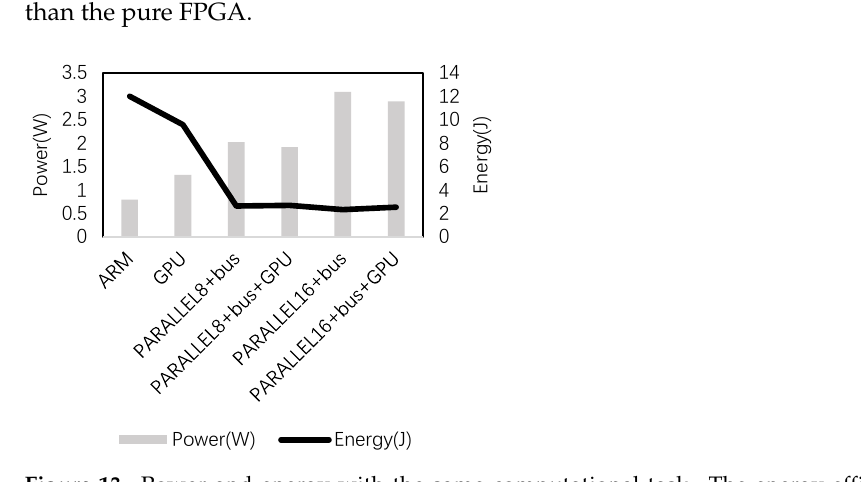
Figure 13. Power and energy with the same computational task. The energy efficiency ratio is inversely proportional to the energy consumed.